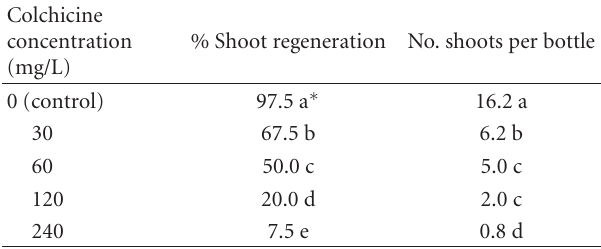
Table 1: Comparison of the e ff ect of colchicine concentration on shoot regeneration from petiole explants. Data were collected after 30 days on regeneration medium containing colchicine and 40 days on colchicine-free regeneration medium except for the control, data for which were collected after 40 days of culture without transfer to new